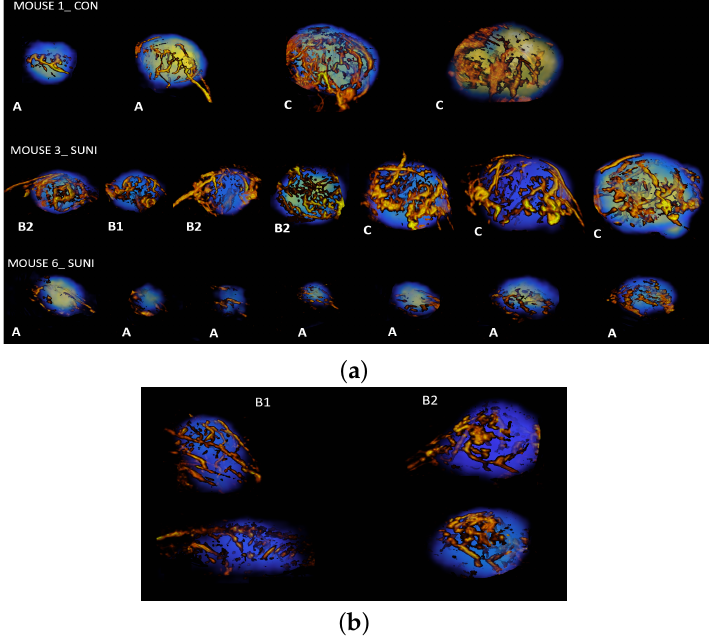
Figure 6. Maximum intensity projection renderings (MIP) of PGL tumors, ( a ) mouse 1 from the CON group, mouse 3 and mouse 6 from the SUNI group. Tumors in the CON group are shown at baseline and from week 1 to week 3, while tumors from the SUNI group are shown at baseline and at week 1 to week 6. ( b ) Comparison of PGL tumors at the B 1 t and B 2 t